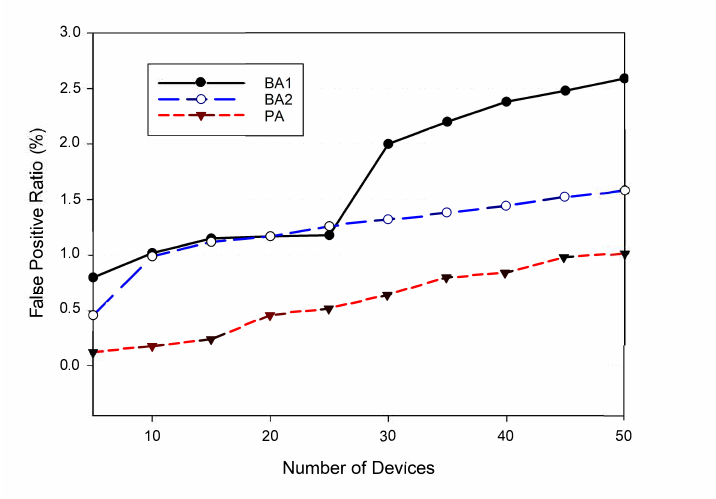
Figure 3. False positive ratio of the proposed approach compared to the baseline approaches.